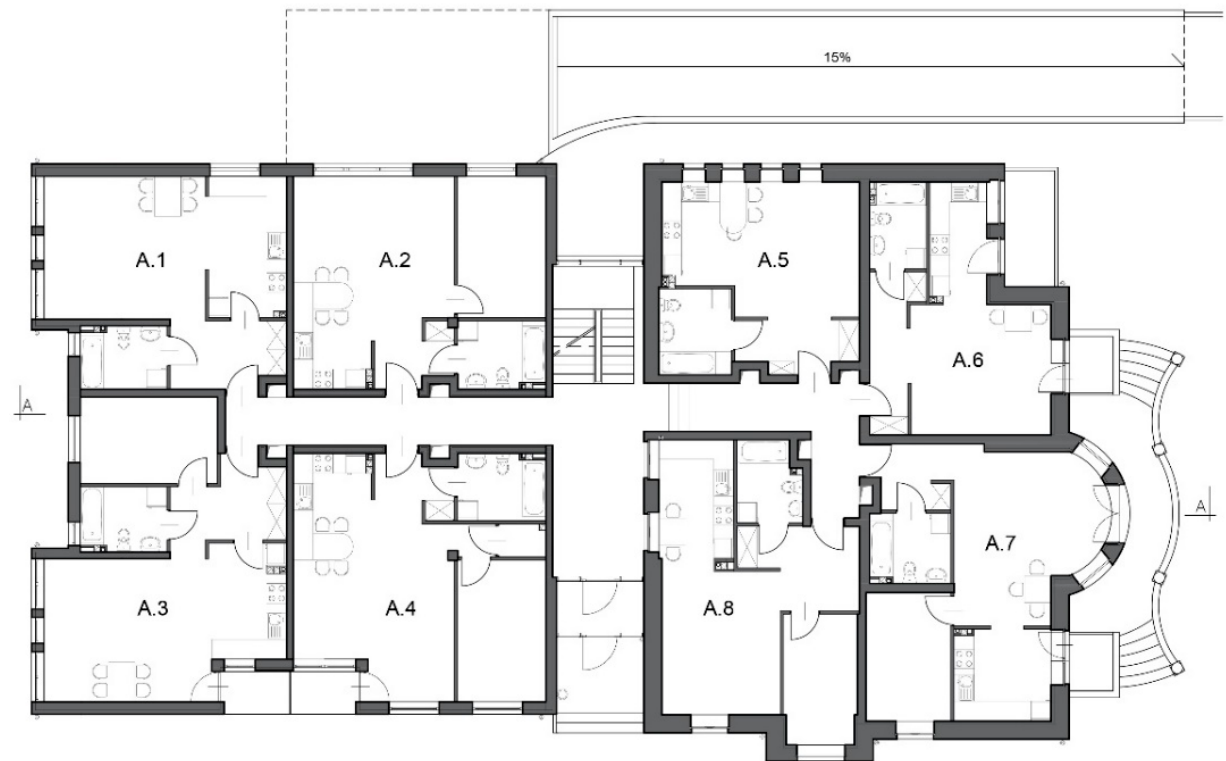
Figure 11. Willa Halina extension design ; ground floor plan. Source: A. Taraszkiewicz.